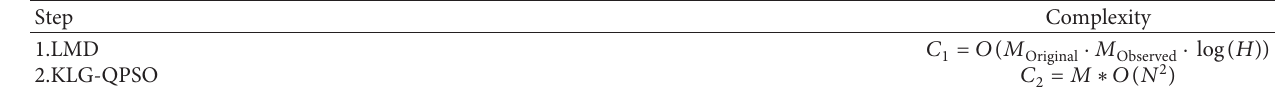
Table 6: Complexity of speech signal extraction and separation